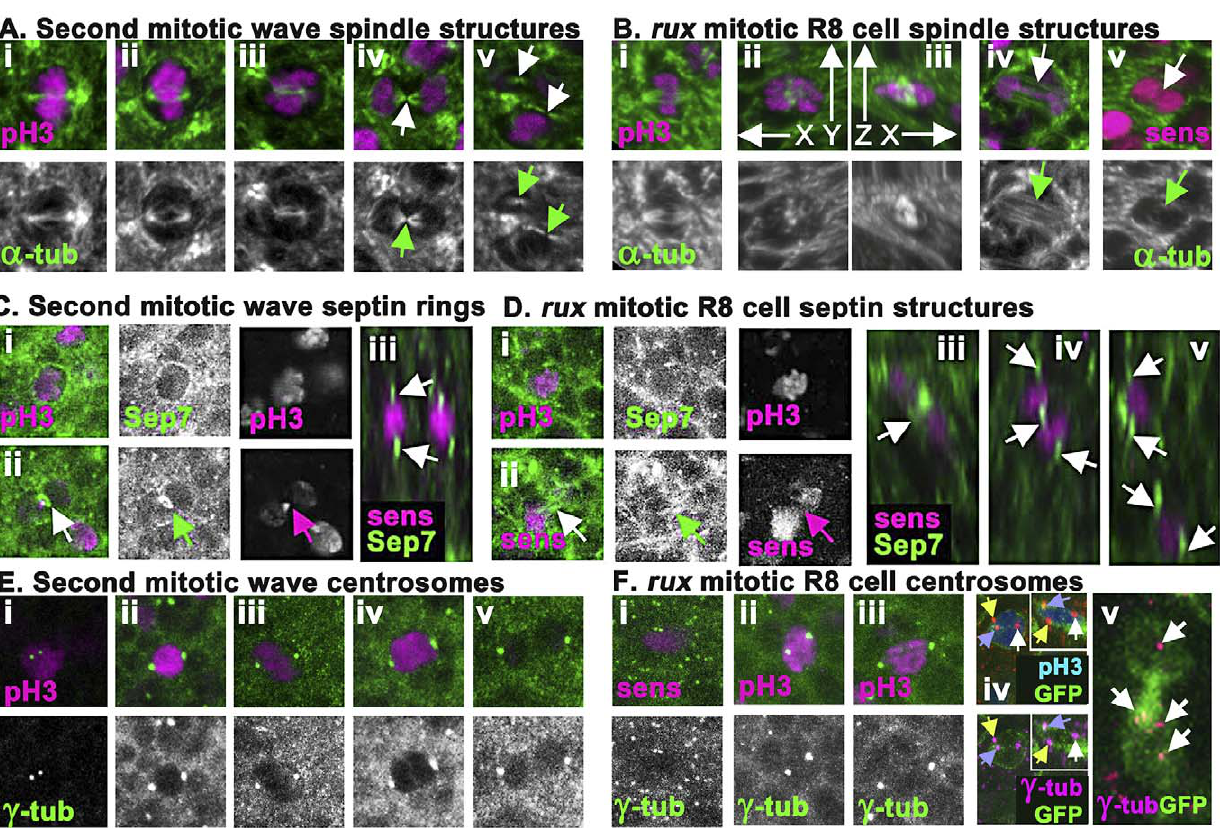
Figure 4. rux mutant R8 nuclei separate but exhibit late mitotic defects. (A) Wild type second mitotic wave cells labeled with a -tubulin (green): prophase (i) metaphase (ii) early anaphase (iii), the central spindle (arrow) of a late anaphase cell (iv), and the midbodies indicative of telophase/cytokinesis (arrows) (v). (B) a -tubulin staining (green) of mitotic R8 cells from rux eye discs: a metaphase R8 cell with a spindle parallel to the epithelial surface (i), confocal section through a metaphase R8 cell with a vertically oriented spindle (ii) and a rotated reconstruction of the same cell with apical uppermost (iii). (iv) an R8 cell in anaphase in column 3. Arrow highlights absence of a midbody. (v) an R8 cell in anaphase in column 5. Arrow highlights no apparent central spindle. (C) Septin-7 (green) and H3p or Sens labeling of WT second mitotic waves cells in prophase (i) and telophase (ii). Arrow indicates contractile ring. (iii). An x-y reconstruction of the eye disc showing focal concentrations of Septin-7 apical and basal to photoreceptor nuclei. (D) Septin-7 staining of mitotic R8 cells in prophase (i). Although Septin7 sometmes seems elevated between telophase pronuclei (arrow), no contractile ring is appears (ii). (iii–v) x-y reconstructions of rux eye discs showing Septin-7 foci near photoreceptor nuclei, as in wild type. (E) U tubulin (green) and H3p (magenta). Prophase cell with recently duplicated centrosomes (i), prometaphase cell (ii), metaphase cell (iii), anaphase cell (iv) and telophase cell (v). Note the background of many tiny foci of U tubulin labeling in addition to the centrosomes, thought to represent the location of centrosomes at the apex of G1 cells [56]. (F) U tubulin and Sens or H3p (magenta) in R8 cells from rux eye discs: a prophase (i), prometaphase (ii), metaphase (iii). The background of small U tubulin foci typical of G1 interphase cells in wild type is replaced in rux by apical centrosomes of many dividing cells (i). These are less apparent in panels (ii) and (iii) because R8 nuclei are typically more basally located at these stages. (iv) A subset of mitotic R8 cells appear to contain extra centrosomes. (v) x-z reconstruction confirms that all three centrosomes share one R8 cell. (vi) A binucleated R8 cell in column 7containing multiple U tubulin structures (the U -tubulin signal has been gain amplified to reveal these weakly-stained structures). See also Figure S2.